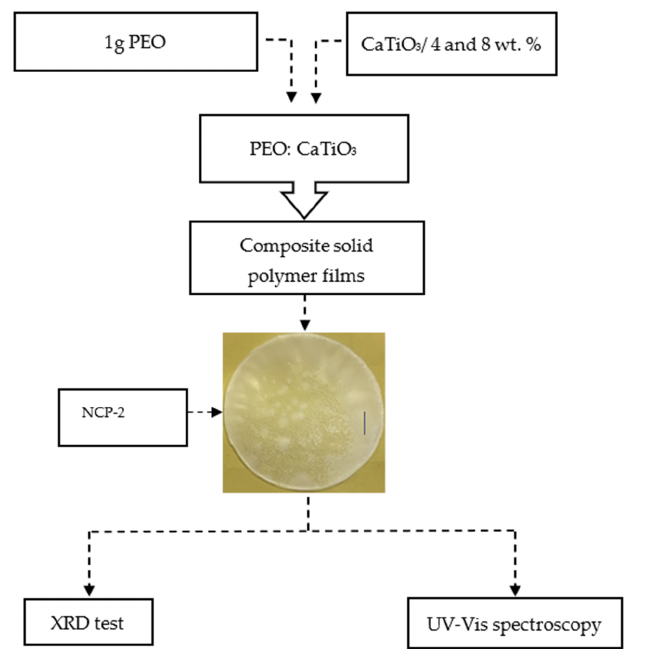
Figure 1. Flowchart of the composite preparation process and picture of composite membrane.